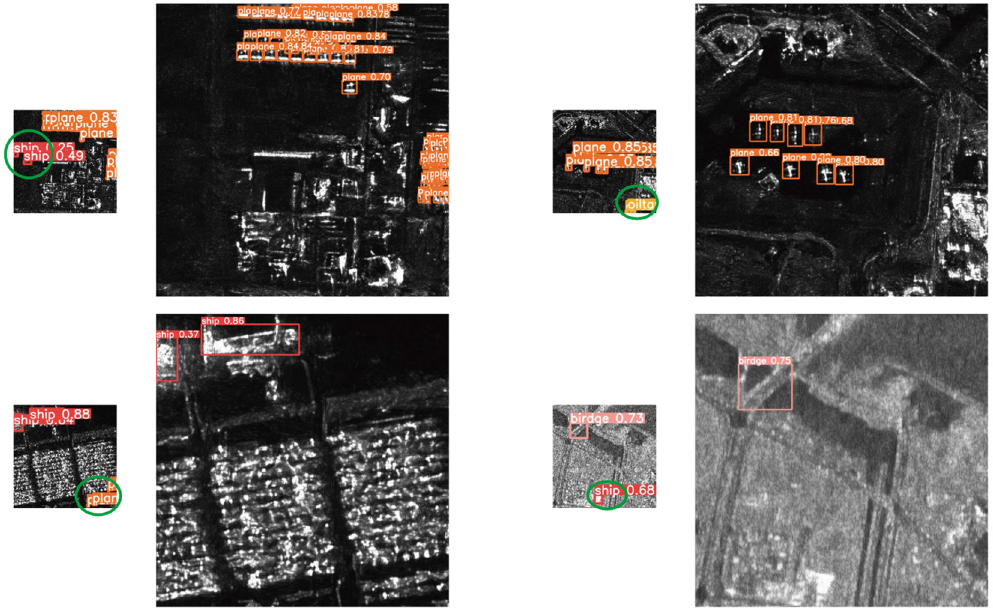
Figure 12. Illustration of false alarms. Green circles mark fault detection. The left is the detection results without SR process and the right is processed in SR at a factor of 4. Different colors means different kinds of targets.